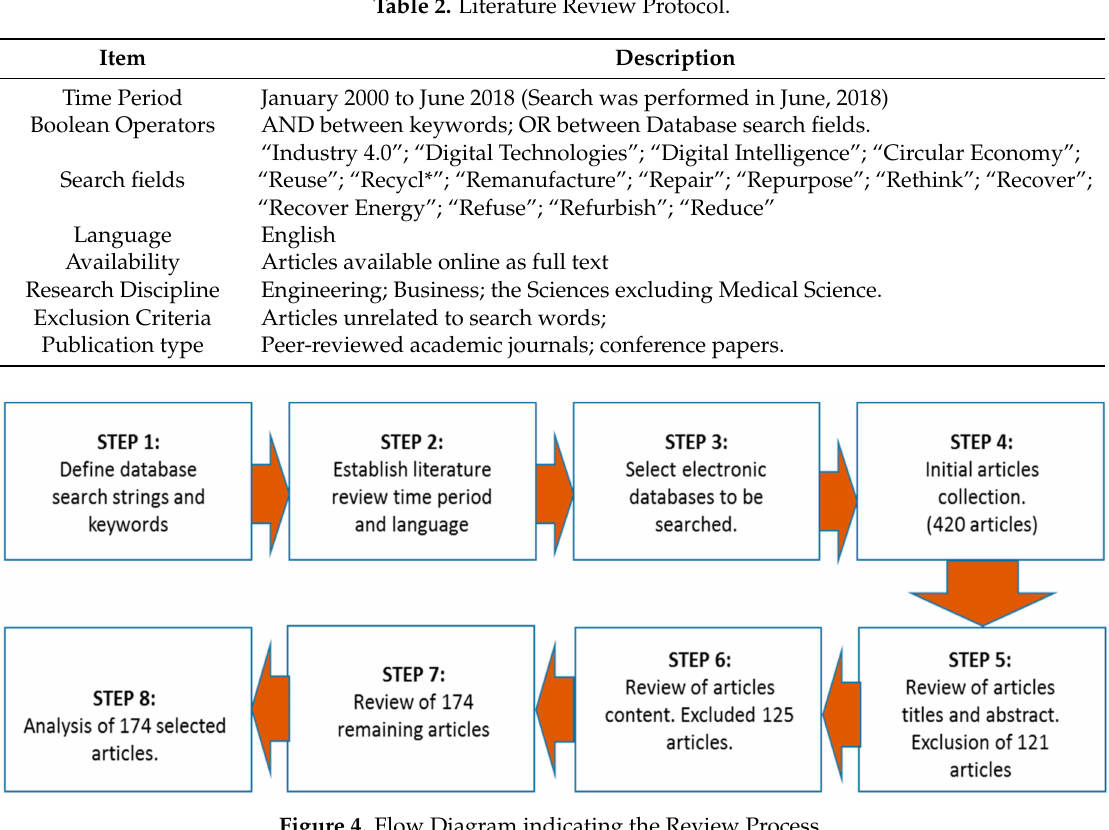
Figure 4. Flow Diagram indicating the Review